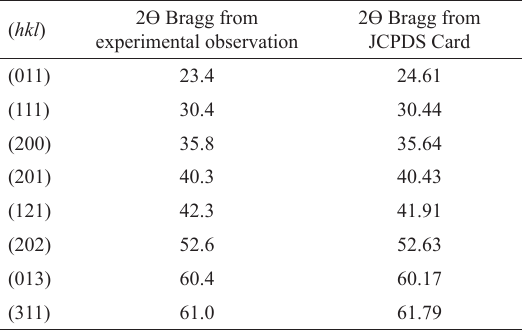
Table 2: Estimated peak 2Ɵ Bragg positions of diffraction planes (hkl) of the